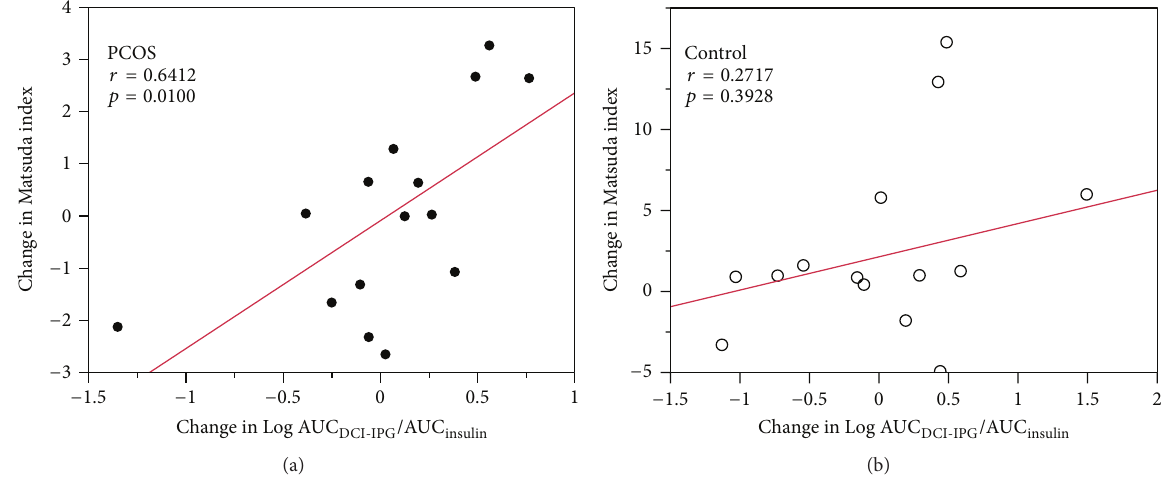
Figure 2: Relationship between change in Matsuda index and change in release of the bioactive DCI-IPG messenger per unit of insulin released during OGTT in PCOS ( e , a) and normal ( l , b) women after 8 weeks of weight loss intervention. DCI-IPG, D-chiro-inositol- inositolphosphoglycan